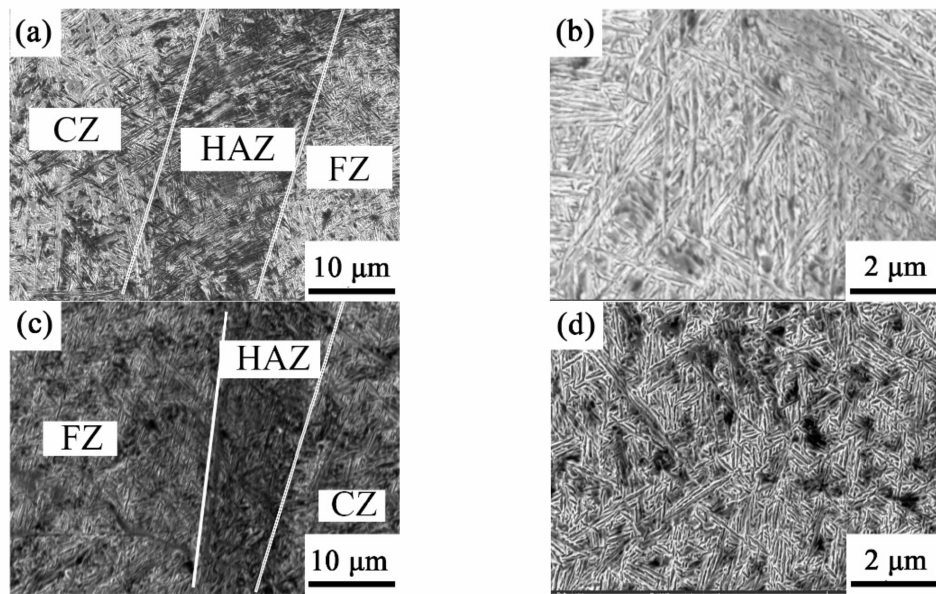
Figure 4. SEM morphology of TMCs: ( a , b ) TC11 titanium alloy; ( c , d ) GNPs/TC11